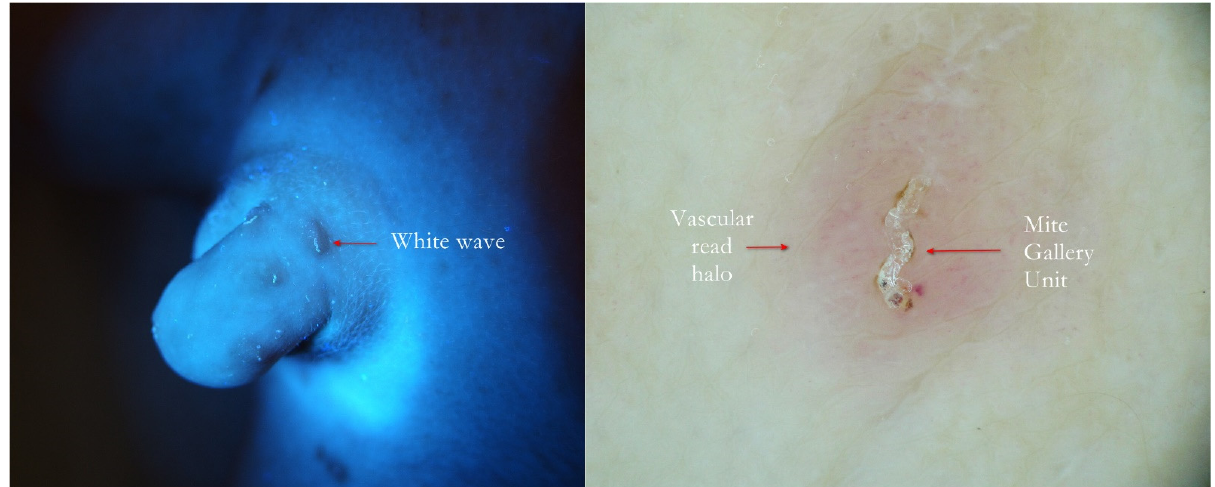
Figure 7. Scabies penile papules. The at ‐ a ‐ glance bright linear UVA track (left red arrow) was con ‐ firmed to be a typical Mite ‐ Gallery Unit surrounded by a pink vascular infiltrate under wet dermos ‐ copy ( right ).